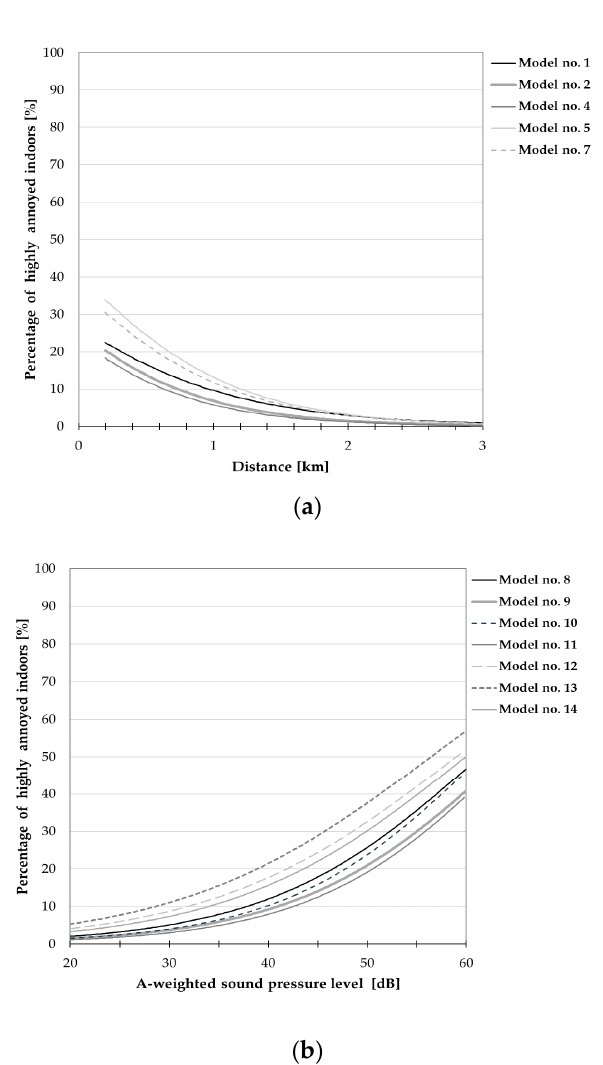
Figure 8. Relationships between the percentage of respondents being highly annoyed indoors and ( a ) noise level or ( b ) distance from the nearest wind turbine. The curves correspond only to those models from Table 13 for which all regression coefficients reached a statistical significance; they were drawn, where applicable, with explanatory variables of “road-traffic intensity” (=1), “sensitivity to noise” (=3) and “attitude to wind farms” (=2) equal to median values in the study group.